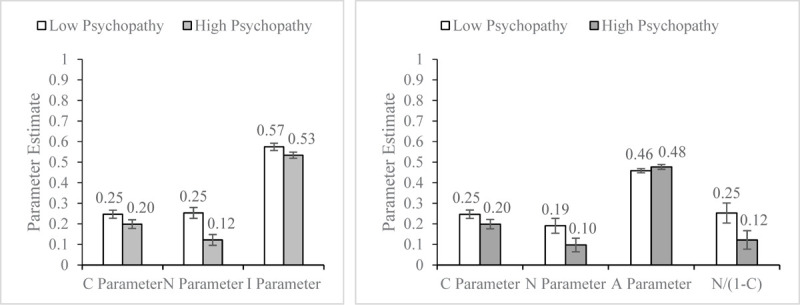
Results of Study 4a by Gawronski et al. (2017) obtained from the CNI model (left) and CAN algorithm (right). Error bars represent ± 1 SE.